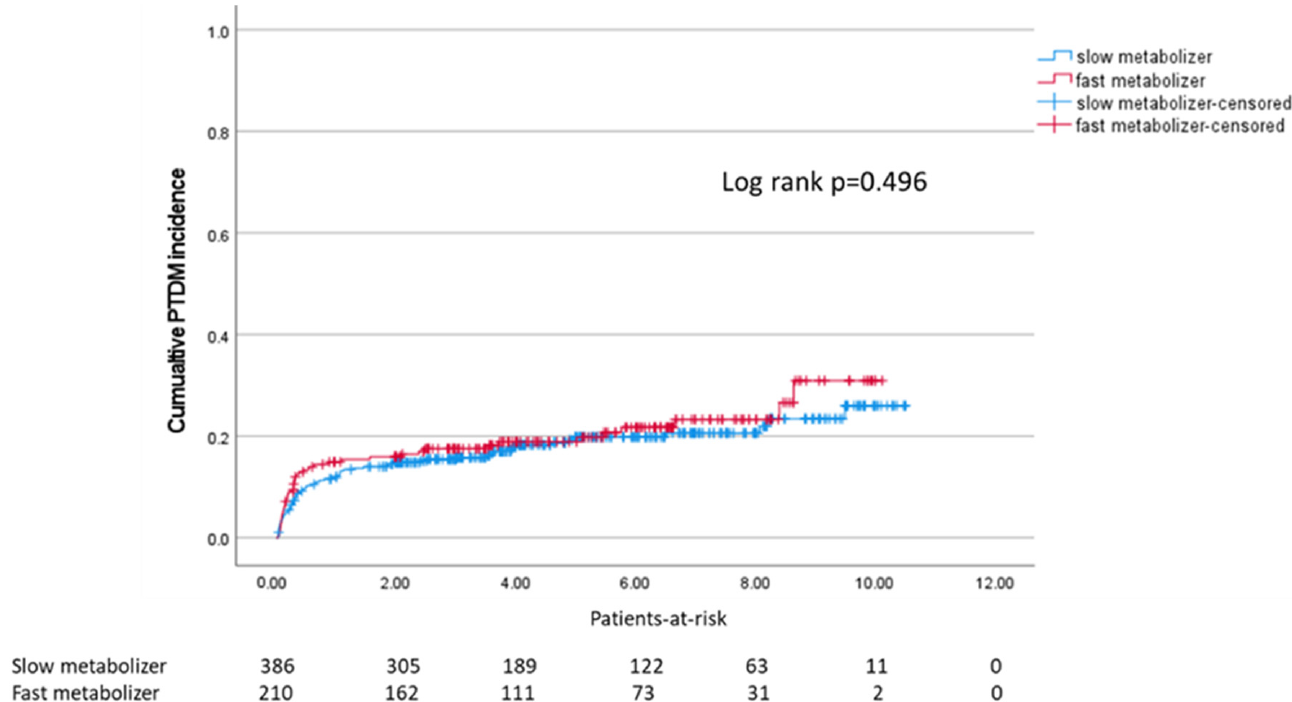
Figure 1. Kaplan–Meier survival plot for incidence of PTDM after transplantation in slow and fast metabolizers (median: 4.0 months).